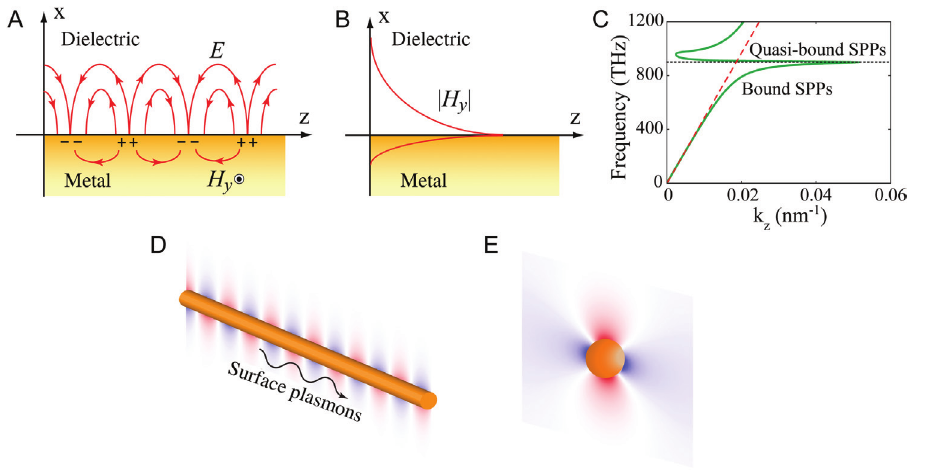
Figure 2 (A) Illustration of SPPs and oscillation of surface charges at the interface between a dielectric and a metal. (B) The electromag- netic field is maximum at the interface and exponentially decays in the direction perpendicular to the interface, reflecting the bound, nonra- diant nature of SPPs. (C) Dispersion curve (green) for SPPs at the silver-air interface. The red dashed line is the light line in air, and the black dotted line represents the surface plasmon resonant frequency at which Re( ε nanowire and a metallic nanoparticle, which are confined in two dimensions and three dimensions, respectively. The false color indicates the electric field of